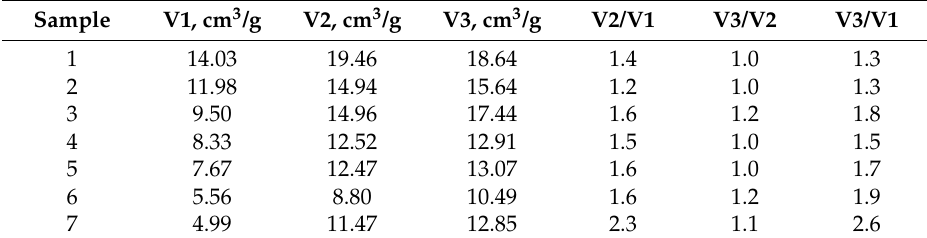
Table 4. The volumes of acetylene sorbed on coals of various grain class: 0.500–0.700 mm